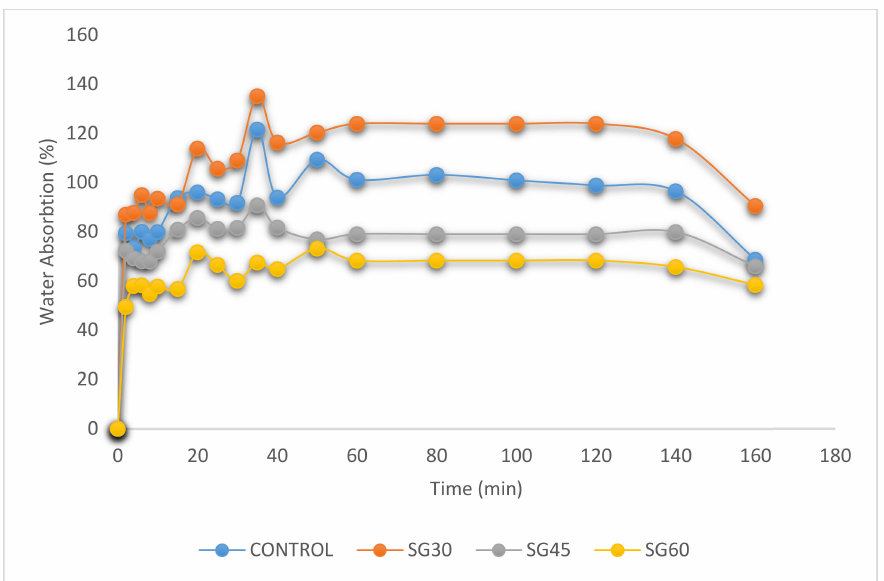
Figure 6. Water absorption on CS films with sorbitol/glycerol